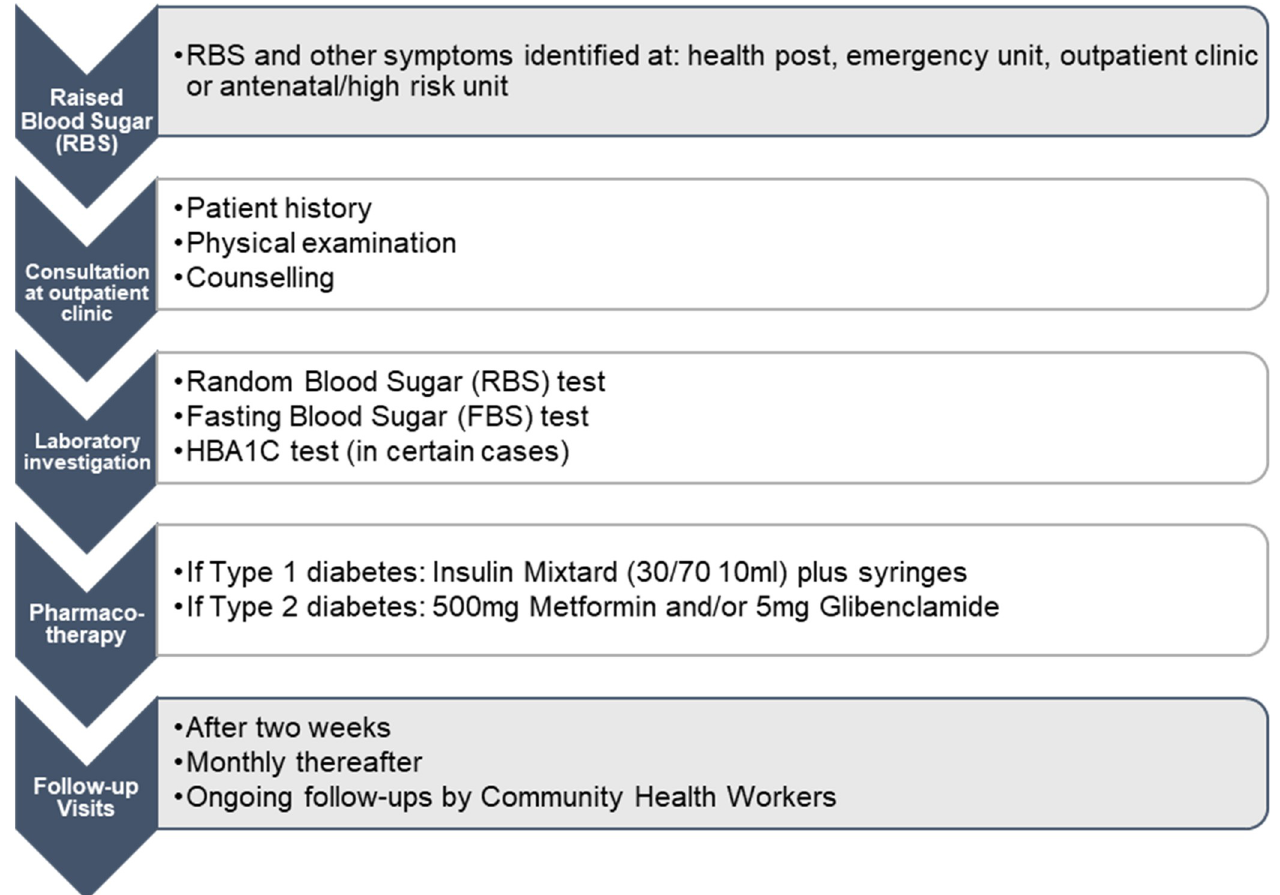
Fig 2. Clinical pathway for care of uncomplicated diabetes